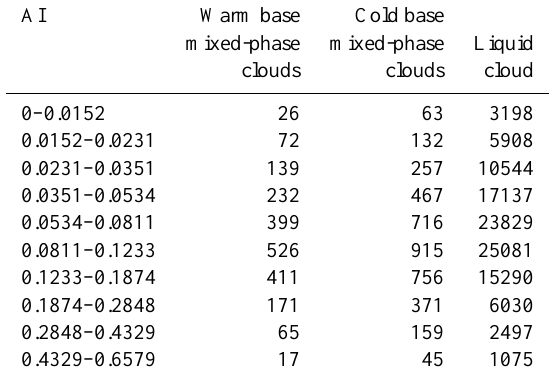
Table 3. Sample sizes for the data points in Fig. 1a and b.